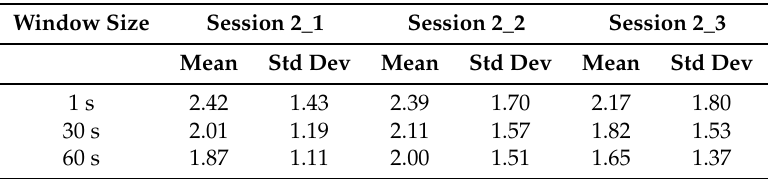
Table 3. Localization error for two-participant sessions, using motion-sensor and BLE-Estimote data, with both participants holding phones. All the measurements are in meters.